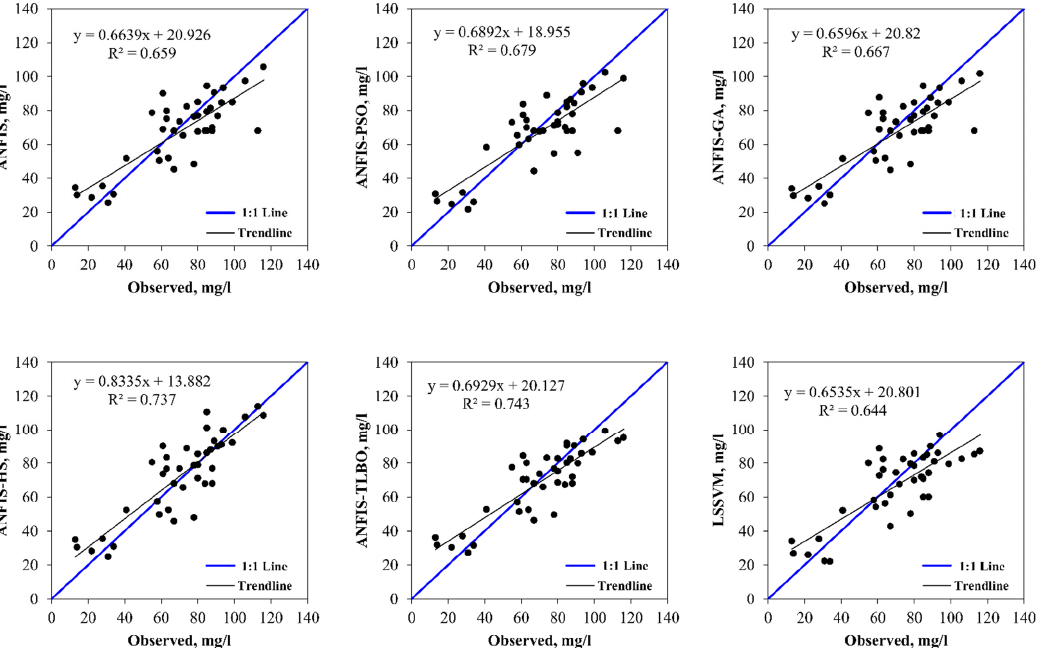
Figure 5. The observed and model-estimated CODs for the M2 data set with AMM, TKN, WT, TC, and as inputs.